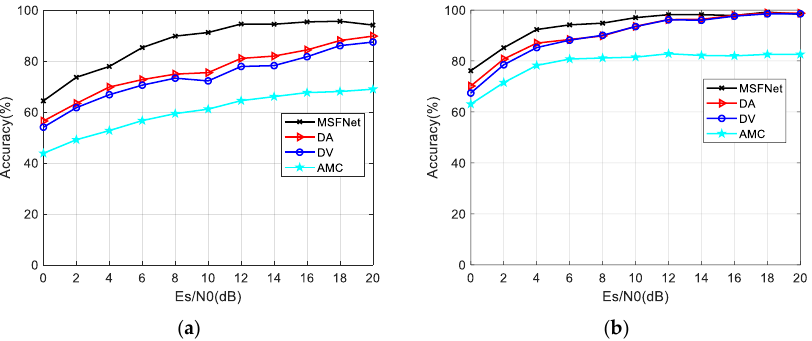
Figure 7. Comparison of recognition performance of different fusion methods. ( a ) M = 3; ( b ) M = 5.